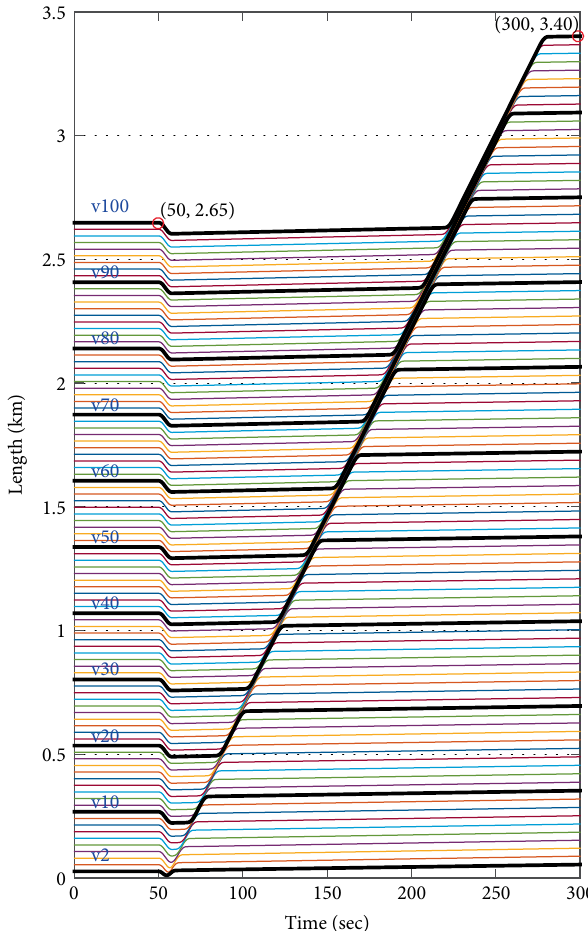
Figure 8: Distance between 1st vehicle and the 99 following vehicles.